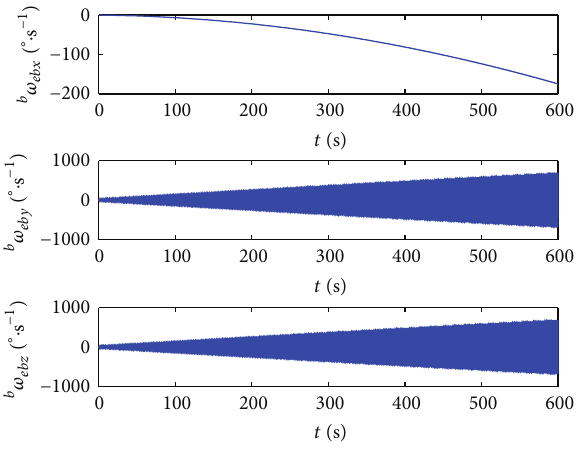
Figure 6: Triaxial angular velocity.